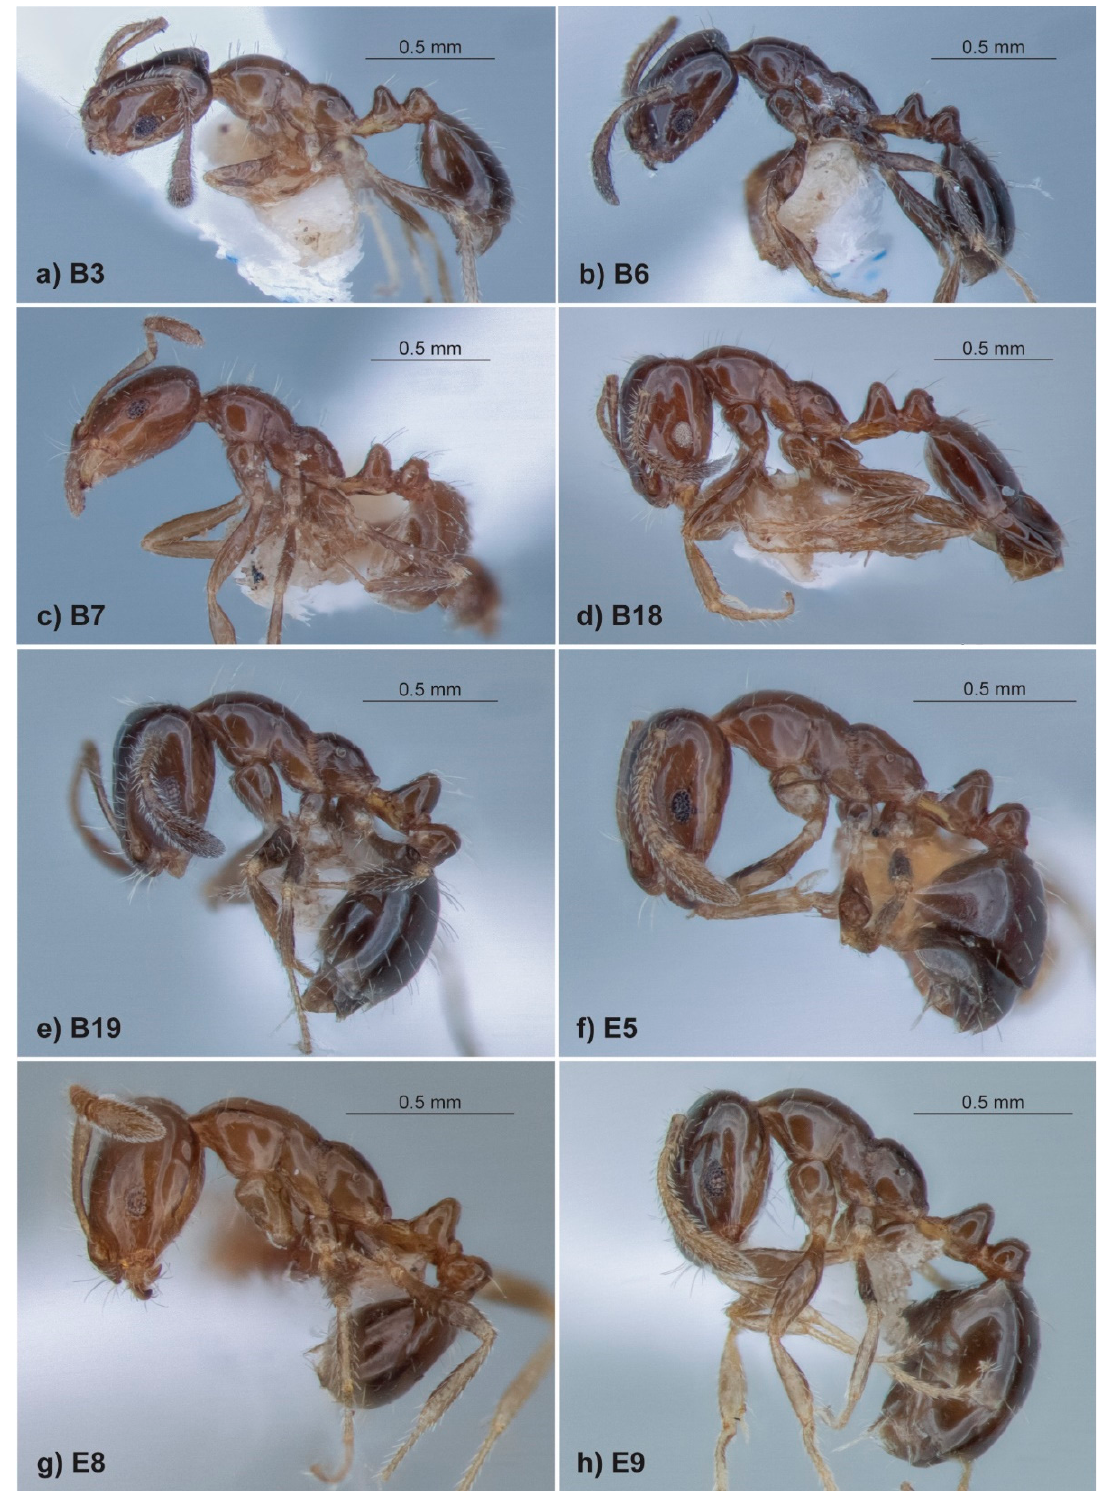
Figure 6. Images of species from the ‘sp. 50’ morphotype. ( a ) Specimen OZBOL3995-16; Forrest Hill Stn, NT; ( b ) specimen OZBOL3996-21; Forrest Hill Stn, NT; ( c ) specimen MONO225-16; Pine Creek, NT; ( d ) specimen MONO266-16; Eurardy Stn, WA; ( e ) specimen OZBOL4005; Hayfield Shenandoah Stn, NT; ( f ) specimen OZBOL1353-21; Ranger Uranium Mine, NT; ( g ) specimen OZBOL1348-21; Gove Peninsula, NT; ( h ) specimen OZBOL4030-21; Hayfield Shenandoah Stn, NT.